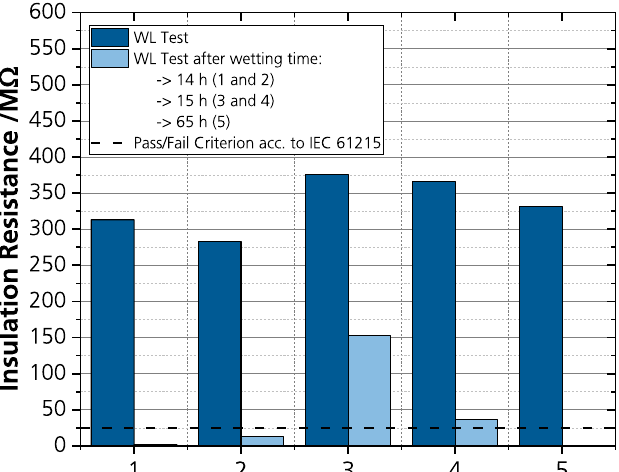
Fig. 4. Wet leakage current test results of fi ve exemplary modules with F-C/PET/PP backsheets from two power plants that have been measured initially and after extended wetting times in a water bath of 14 h (modules 1 and 2), 15 h (modules 3 and 4) and 65h (module